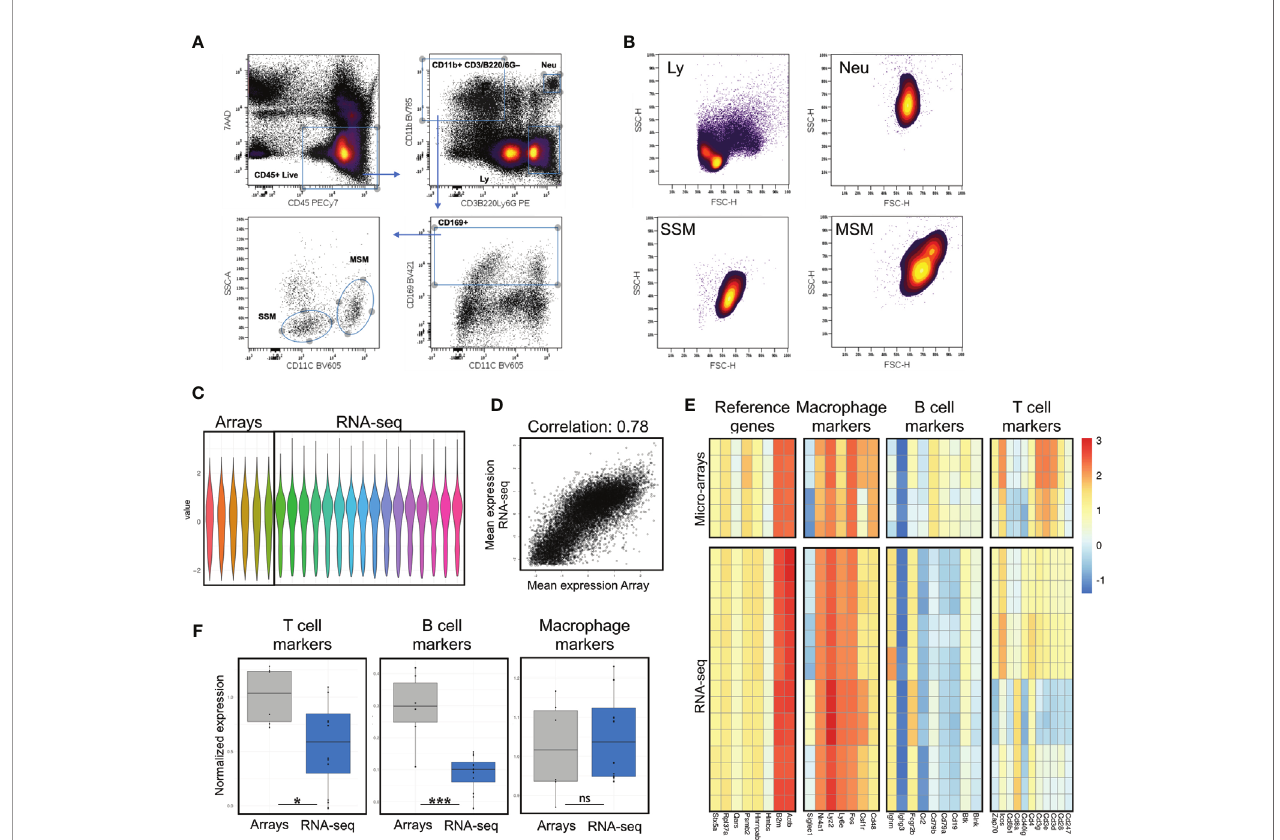
FIGURE 1 | Assessment of potential B and T cell contamination in preparations of lymph node macrophages by comparison with previously published data. (A) Sorting strategy; after excluding cell debris in a FSC/SSC plot, live immune cells are gated as 7AAD-CD45+; a stringent gate for the myeloid marker CD11b excludes potential contaminating events with mixed macrophagic/lymphocytic markers, possibly representing SSM-blebs on B/T cells; myeloid cells are then gated for the lymph node macrophage marker CD169; SSMs and MSMs are best separated on a SSC/CD11c plot. (B) Forward and side scatter parameters of SSM, MSM, lymphocytes (Ly, gated as in A ) and neutrophils (Neu, gated as in A ) are consistent with a macrophagic origin (i.e. bigger and more granular than lymphocytes). (C) Normalized values from gene expression arrays and sequencing data. (D) Normalization of gene expression arrays and sequencing data preserves high correlation between datasets (Pearson correlation 0.78). (E, F) Evaluation of T, B cell and macrophage markers, along with reference genes, shows signi fi cant reduction (F) of both T and B cell contamination in our sequencing data, as compared to previously published array data. Heatmaps show raw data normalized as in (C) Each row is a sample, each column is a gene within the respective panel. Statistical test: Wilcoxon rank sum exact test (*p < 0.05; ***p < 0.001; ns, non-signi fi